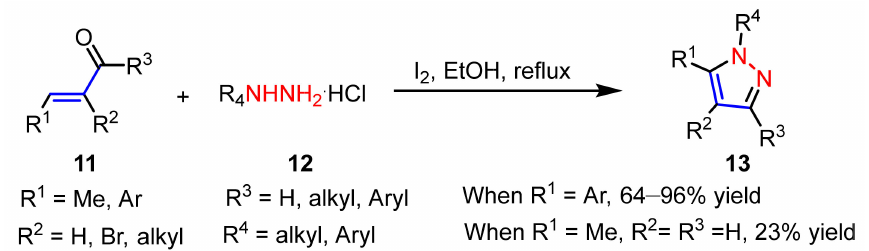
Scheme 7. I 2 -mediated cyclocondensation for pyrazole synthesis.